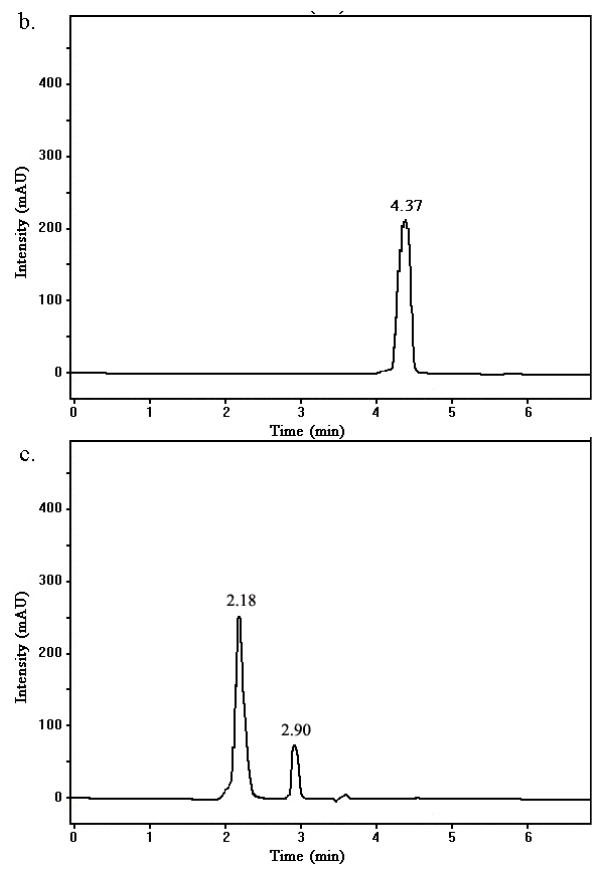
Figure 7. HPLC analysis of PAM samples and acrylamide monomer. ( a ) undegraded PAM sample; ( b ) pure acrylamide monomer; ( c ) PAM sample after